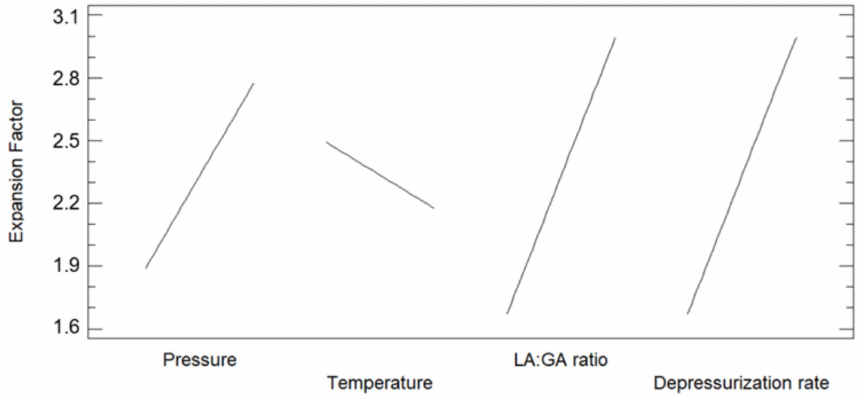
Figure 4. Main effects of the considered variables on the expansion factor of the foamed poly- mer